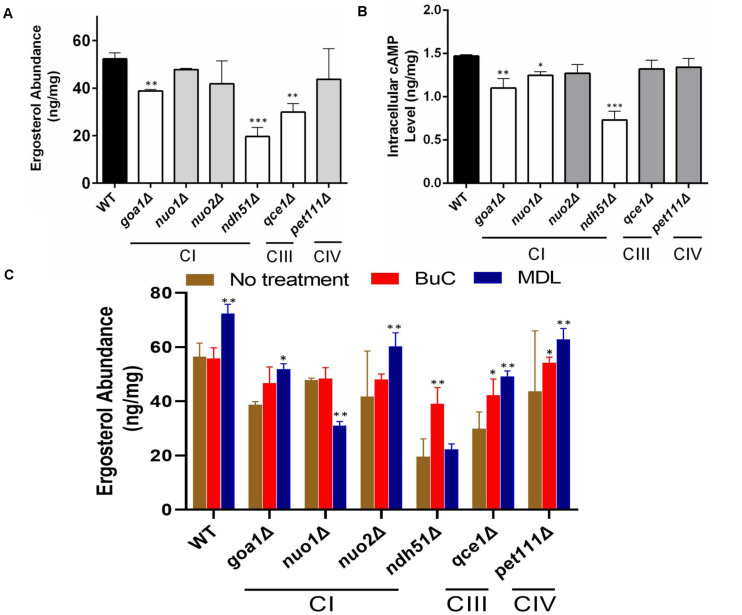
Reduction of ergosterol and cAMP levels varies with each respiration mutant, denoted by their affected ETC complexes: CI, CIII, or CIV null mutants. Ergosterol measurements from cell lysates extracted after 12-h growth in YPD at 30°C of HPLC (A) and cAMP levels from HPLC-MS/MS (B). The ergosterol and cAMP content are presented in units of ng/mg cell lysate for each of the CI, CIII, and CIV mutants and compared with WT strain SN250. First, ergosterol reduction is more pronounced (than in WT) in the CI mutant ndh51Δ (p < 0.001), the CI regulator mutant goa1Δ (p < 0.01), and the CIII mutant qce1Δ (p < 0.01). Second, cellular cAMP concentration is markedly reduced in ndh51Δ (p < 0.001) but less reduced in goa1Δ (p < 0.01) and CI mutant nuo1Δ (p < 0.05). Third, the CIII mutant qce1Δ shows a 33% lower ergosterol level (compared to WT), but its cAMP reduction is less than 10%, while the CIV mutant pet111Δ shows a normal ergosterol level, with less than 10% cAMP reduction. (C) Ergosterol measurement under an agonist and an antagonist of cAMP suggests a negative feedback regulation of ergosterol synthesis upon inhibition of the cAMP/PKA pathway. Under a 4-h treatment with 50 μM BuC, the ergosterol reductions seen in the CI regulator mutant goa1Δ are restored (p > 0.05 versus WT). While no significant change occurs in WT, ergosterol increases 1.89- and 1.3-fold in the CI mutant ndh51Δ and CIII mutant qce1Δ, respectively, compared with their untreated baselines. However, the adenylyl cyclase inhibitor MDL at 50 μM concentration slightly elevates ergosterol content in WT and in most mutants (except for ndh51Δ and nuo1Δ). On the other hand, MDL suppresses ergosterol levels in nuo1Δ (p < 0.01) versus WT but that treatment cannot further suppress ergosterol levels in ndh51Δ. All experiments run in triplicate, with error bars generated from the triplicate data. p values are shown as “***” for <0.001, “**” for <0.01, and “*” for <0.05.